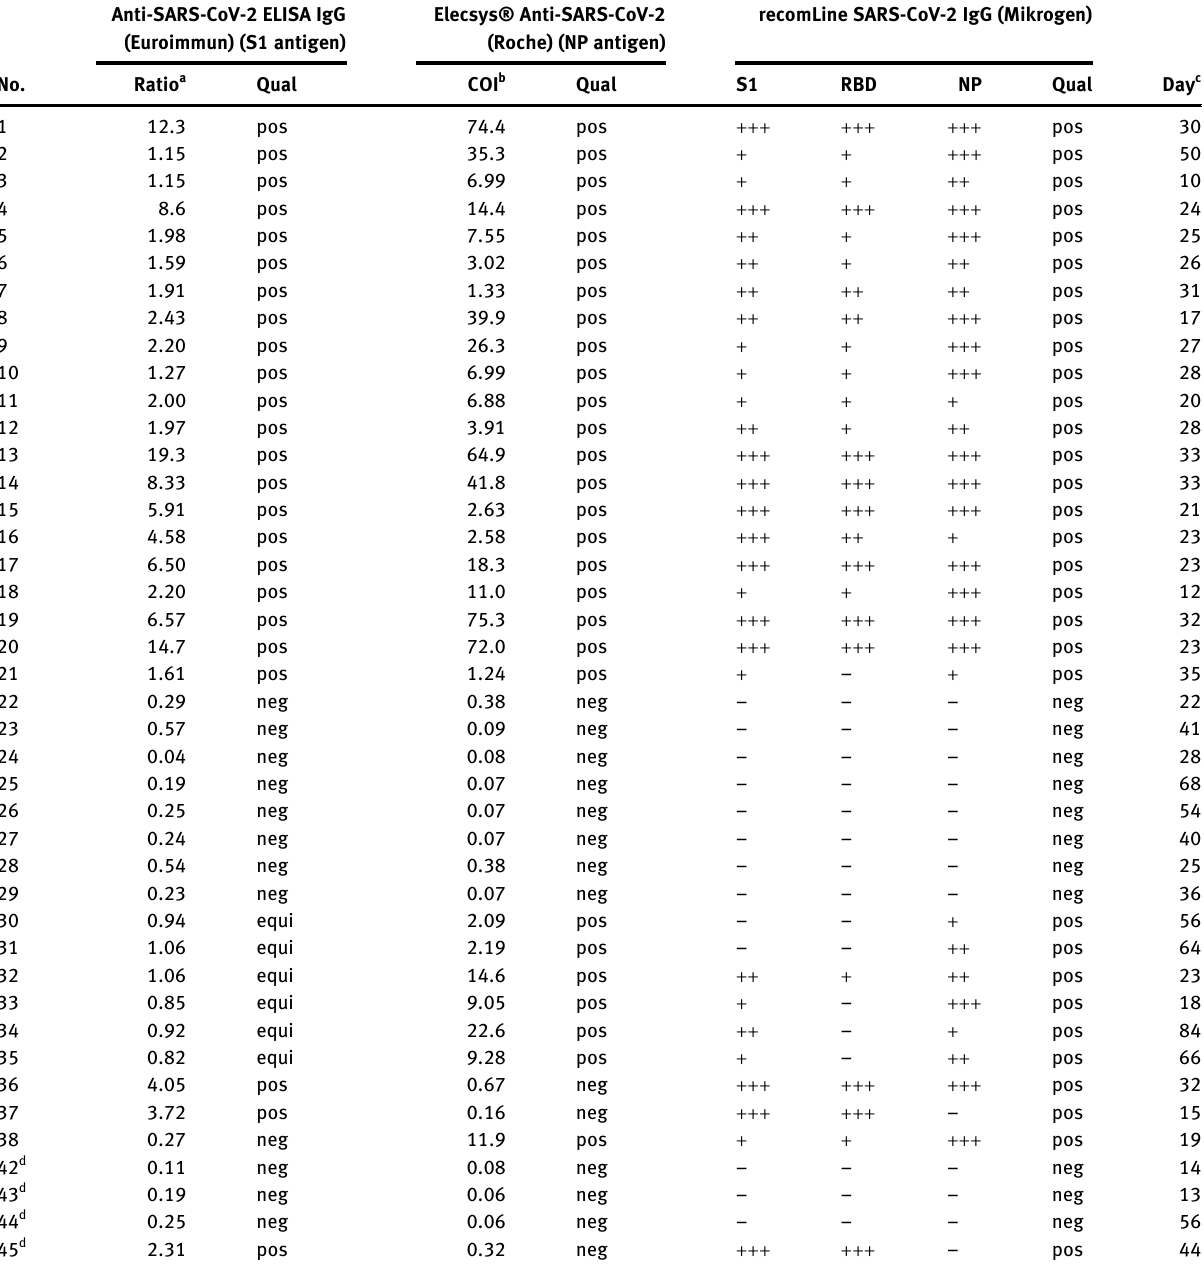
Table  : Results of immunoassays and SARS-CoV-  IgG recomLine assay in PCR-con fi rmed COVID-  patients and asymptomatic contact